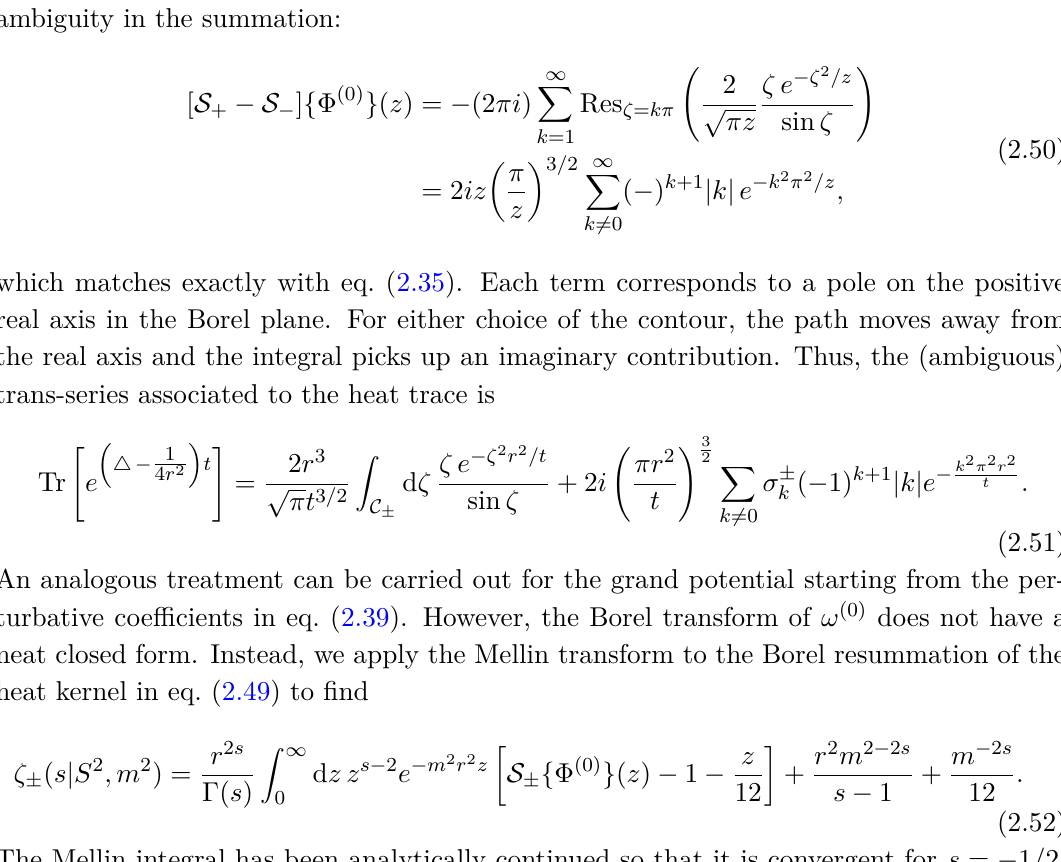
The Borel integral however is ill-defined: the integrand has simple poles on the inte- gration path for ζ = kπ , k = ∈ Z + , which indicate that the series is not Borel